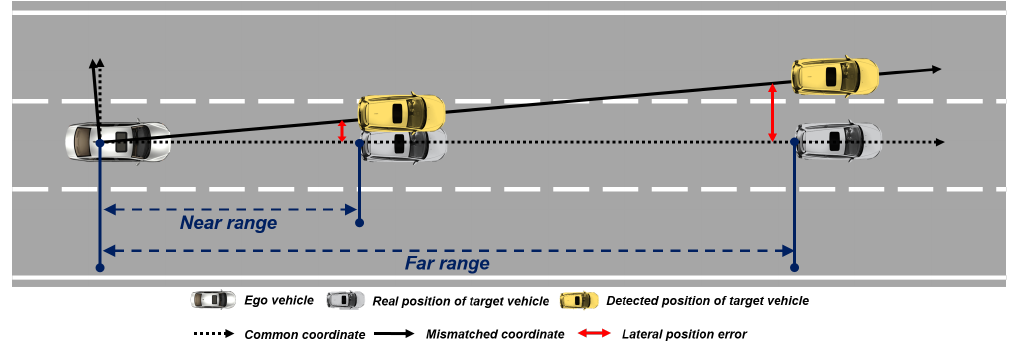
Figure 1. The serious effect of the mismatched coordinate to the distant